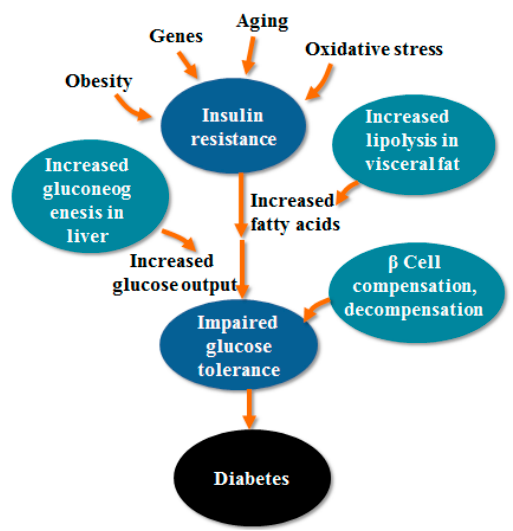
Figure 1. Pathogenesis of T2DM.